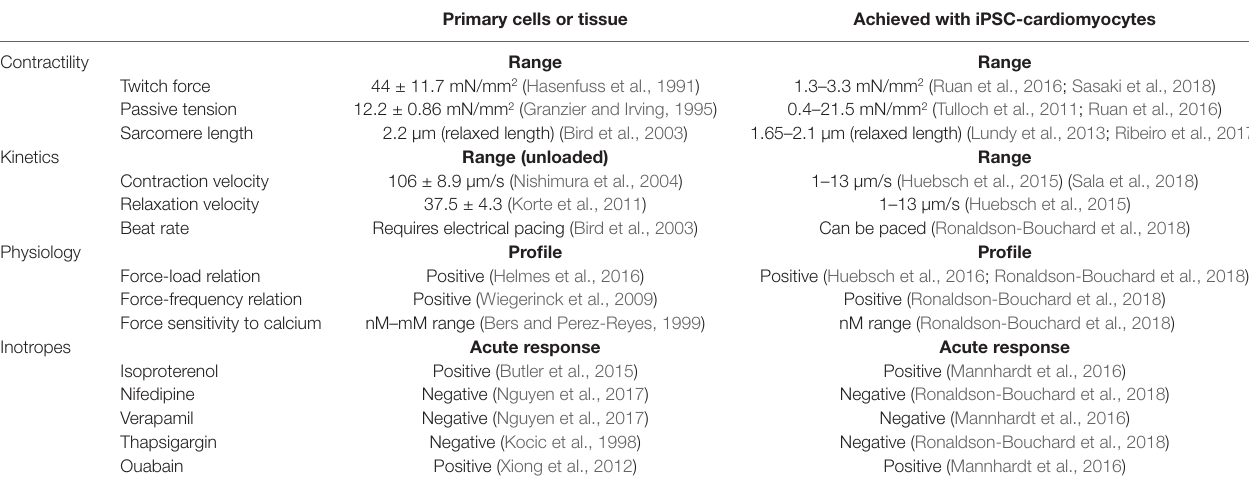
TABLE 1 | Set of parameters obtained from in vitro contractility assays. We present values of these parameters for primary cells or tissue in parallel with measurements from platforms where hiPSC-cardiomyocytes were cultured in a physiologically relevant microenvironment. Primary cells or tissue Achieved with